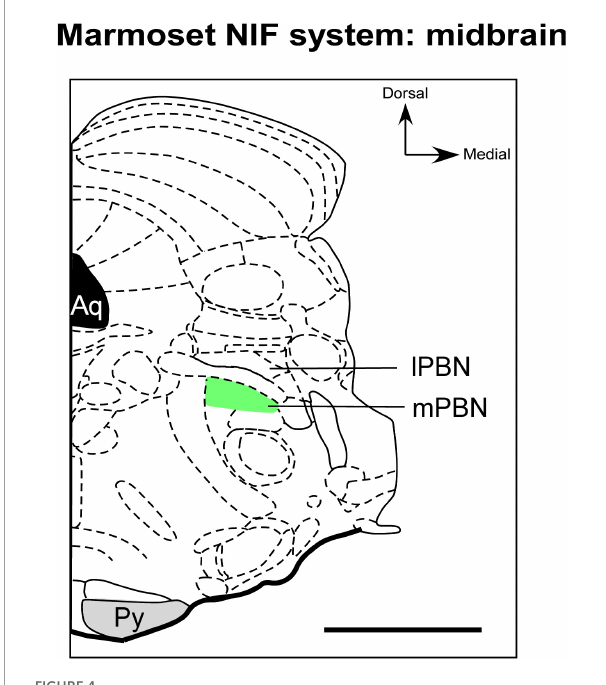
FIGURE4 Schematic representation of the parabrachial complex in coronal section of the marmoset brain. The types of RGCs that send afferents to mPBN (green), a NIF site in midbrain, have not yet been documented in marmoset. aq, cerebral aqueduct; lPBN, lateral parabrachial nucleus; mPBN, medial parabrachial nucleus; Py, pyramidal tract. Scale bar: 500 µ m. Adapted from Paxinos et al.